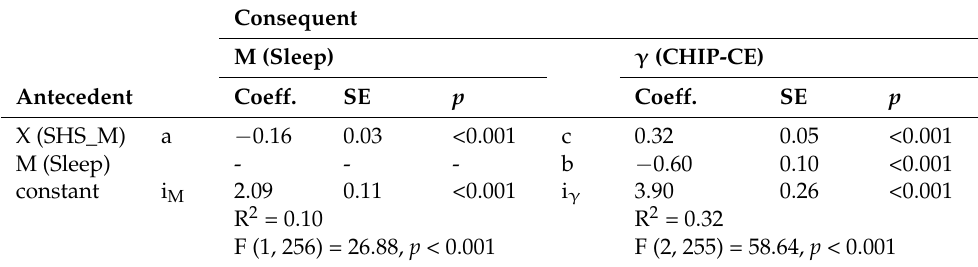
Table 5. Mediation effect of the sleep quality in the link between safe-haven support from the mother (SHS_M) and overall well-being.